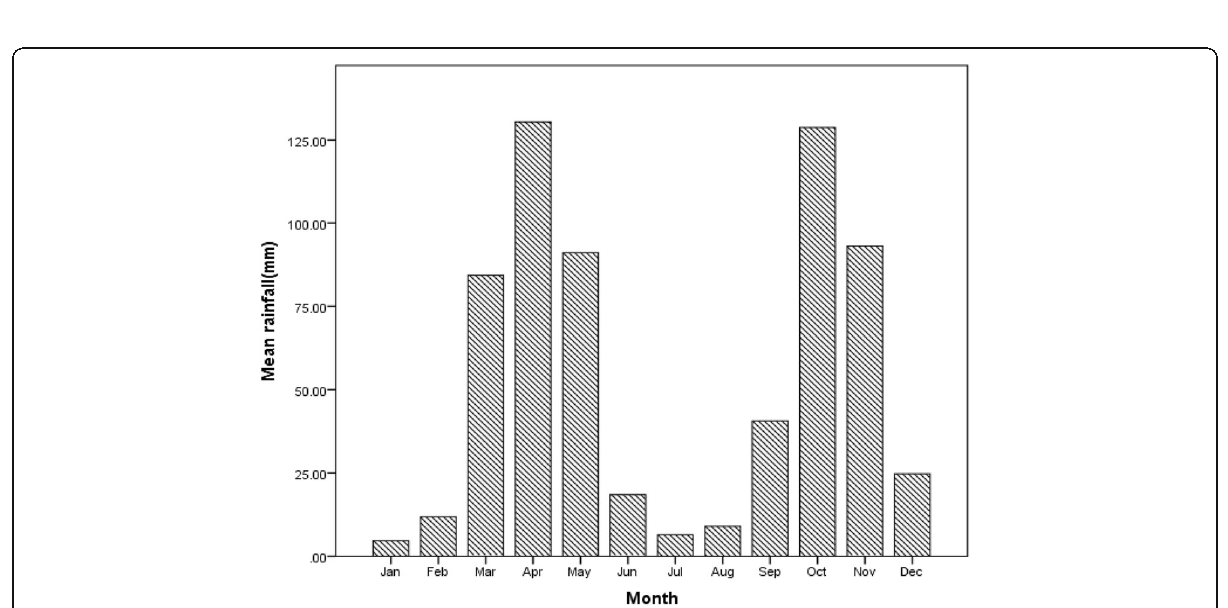
Fig. 2 Mean monthly rainfalls over a period of 22 years in the study